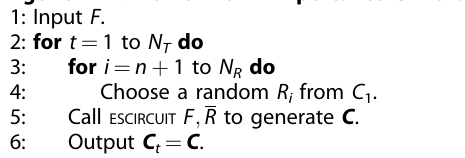
Algorithm 2 . Non-uniform importance Clifford sampling . 1: Input F .